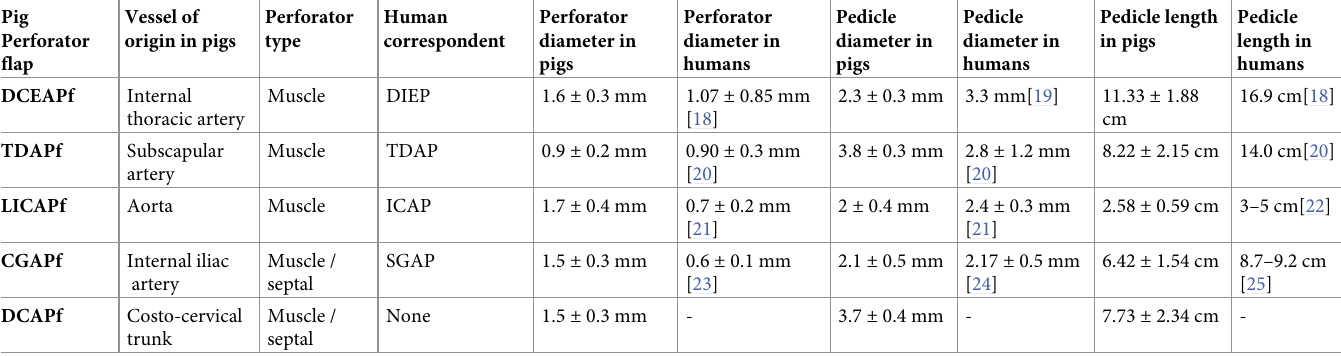
Table 1. Comparison between pig perforator flaps and human